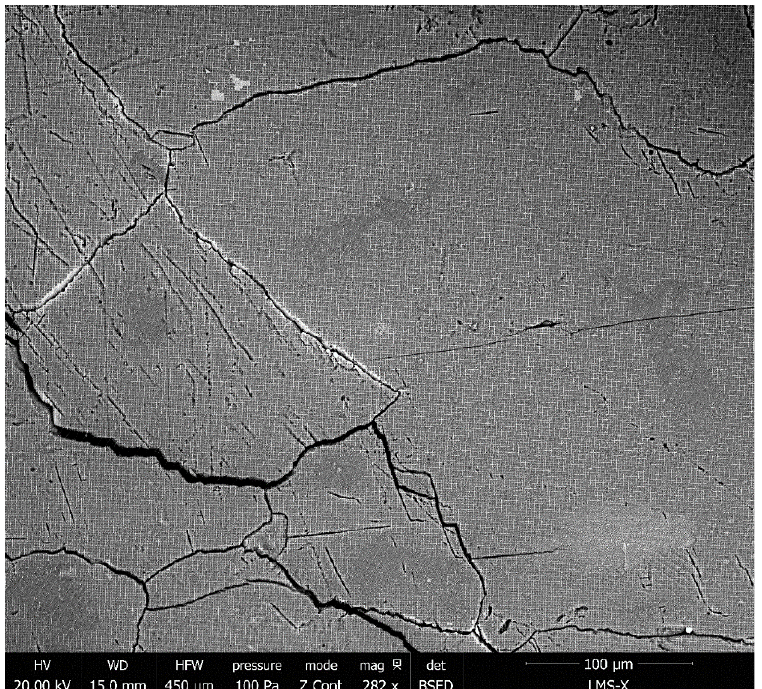
Figure 3. SEM photograph of Carrara marble samples with lithography gold marking of the surface. The photograph is the last one taken before the sample was completely disintegrated during the loading experiment.